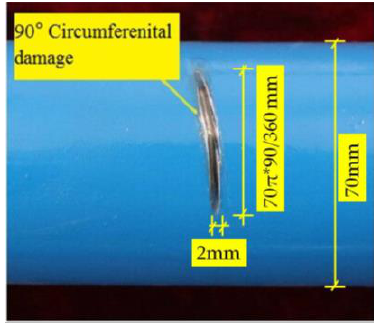
Figure 24. Artificial circumferential damage with a radius angle of 90° in detail.